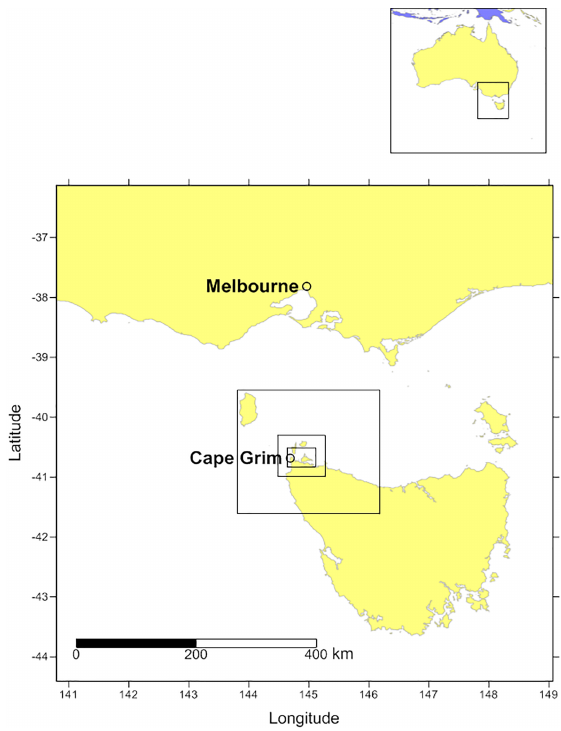
Figure 1. The five nested computational domains used in TAPM– CTM and CCAM–CTM, which had cell spacings of 20, 12, 3, and 1km and